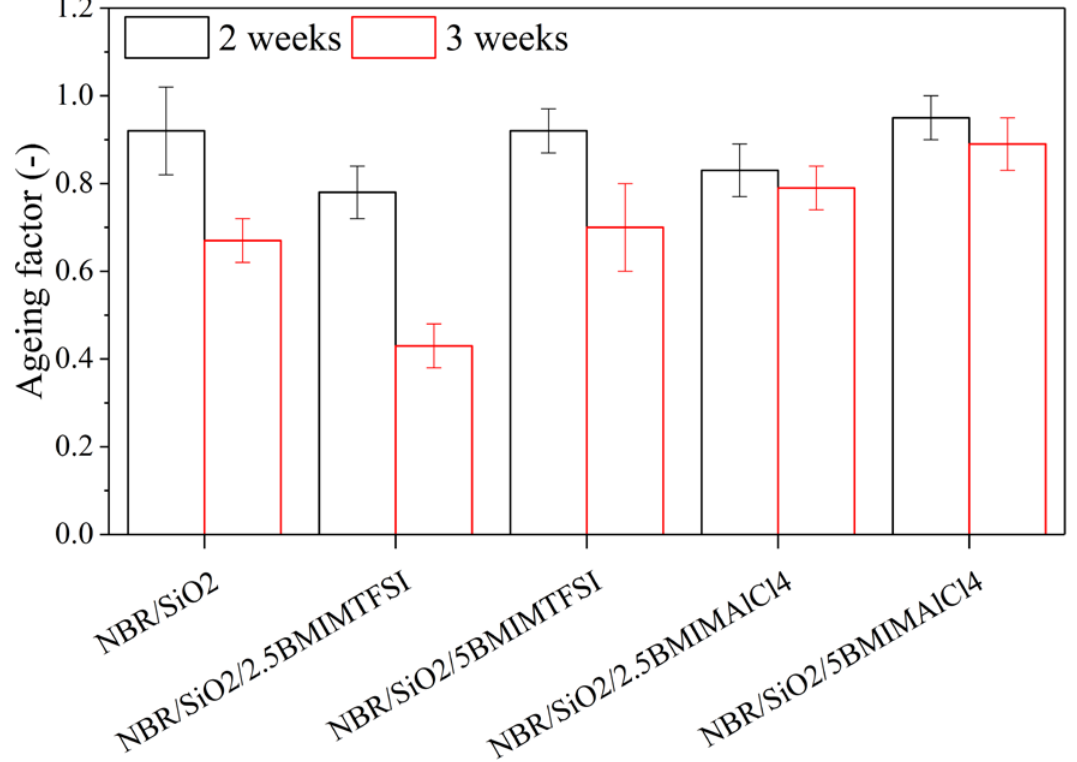
Figure 6. Ageing factor of NBR composites after two and three weeks of thermooxidative ageing.